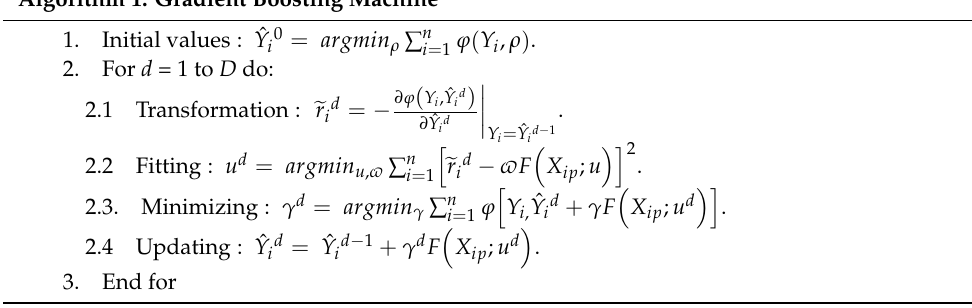
Algorithm 1. Gradient Boosting